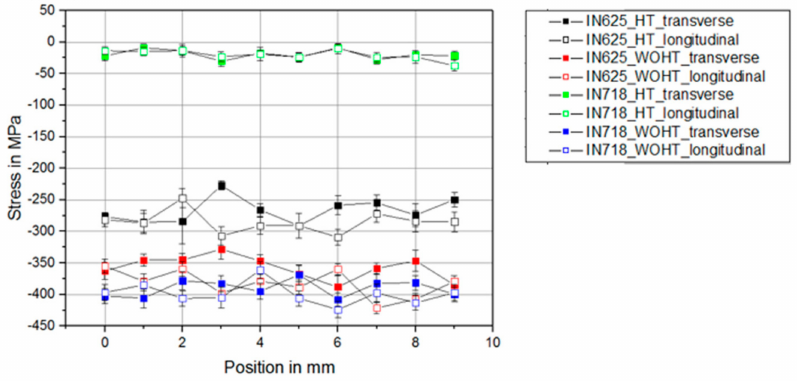
Figure 6. Residual stress profiles of the base SLM material.